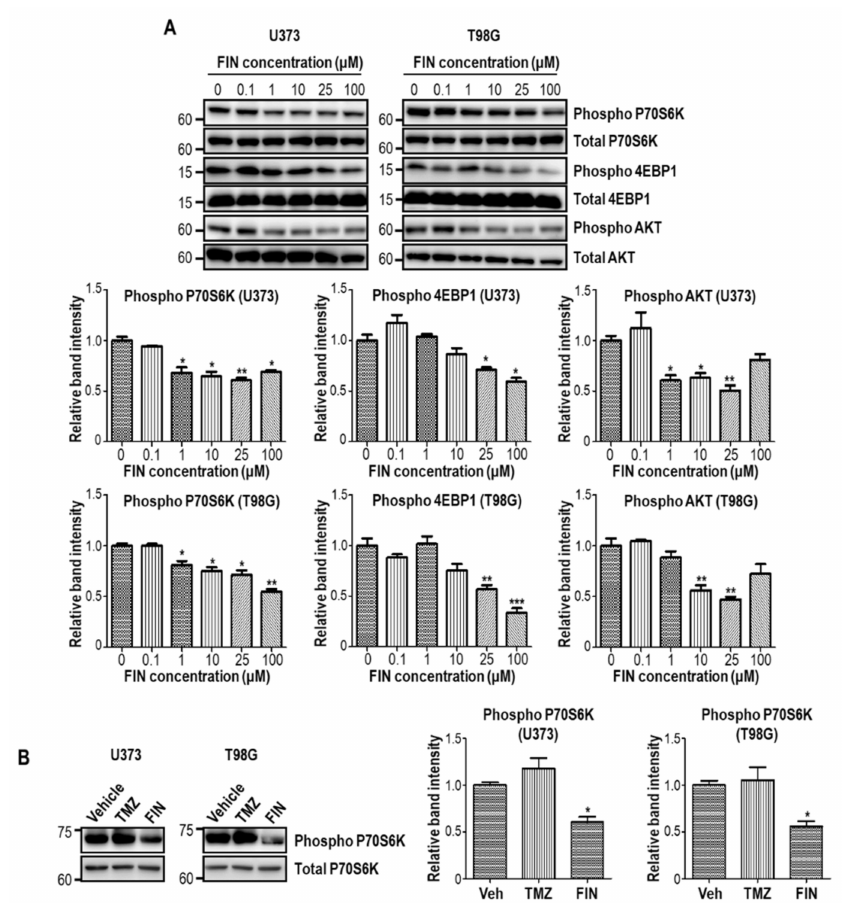
Figure 4. High-dose finasteride inhibits AKT/mTOR pathway in glioblastoma cells. ( A ) U373 (left) and T98G (right) cells were treated with DMSO or various concentrations of finasteride (FIN) for 24 h. Protein levels of phospho P70S6K, P70S6K, phospho 4EBP1, 4EBP1, phospho AKT, and AKT were detected by Western blot assay. The relative band intensities of the phospho proteins are shown below. The intensities of vehicle-treated samples were arbitrarily set to 1. ( B ) Immunoblot analysis of phospho P70S6K in U373 (left) or T98G (right) cells upon treatment of DMSO or temozolomide (TMZ) or 100 µ M FIN for 24 h. P70S6K was used as a loading control. The relative band intensities of phospho P70S6K are represented. The intensities of vehicle-treated samples were arbitrarily set to 1. * p < 0.05, ** p < 0.01, *** p <